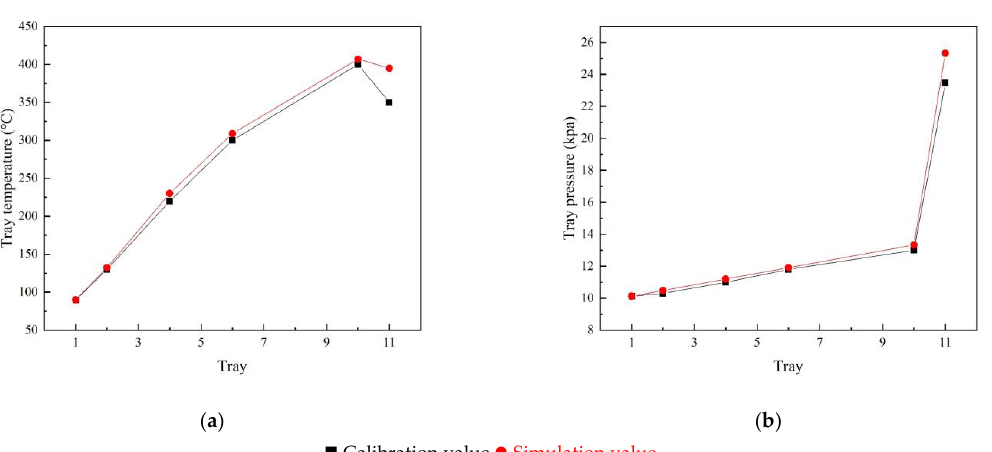
Figure 7. Comparison of tray data of strict model. ( a ) Tray temperature comparison; ( b ) tray pressure comparison.